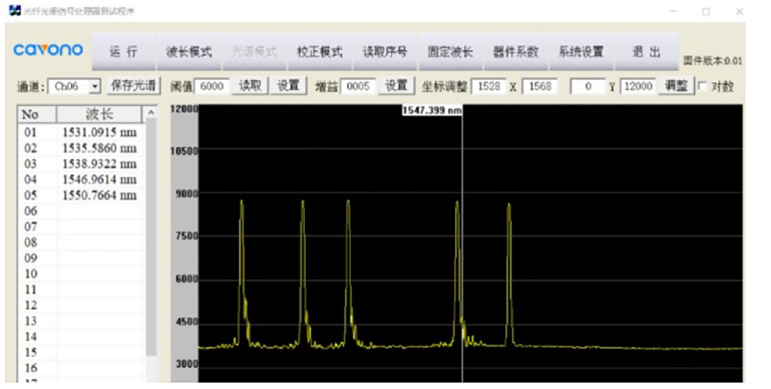
Fig 12. The monitoring data of central